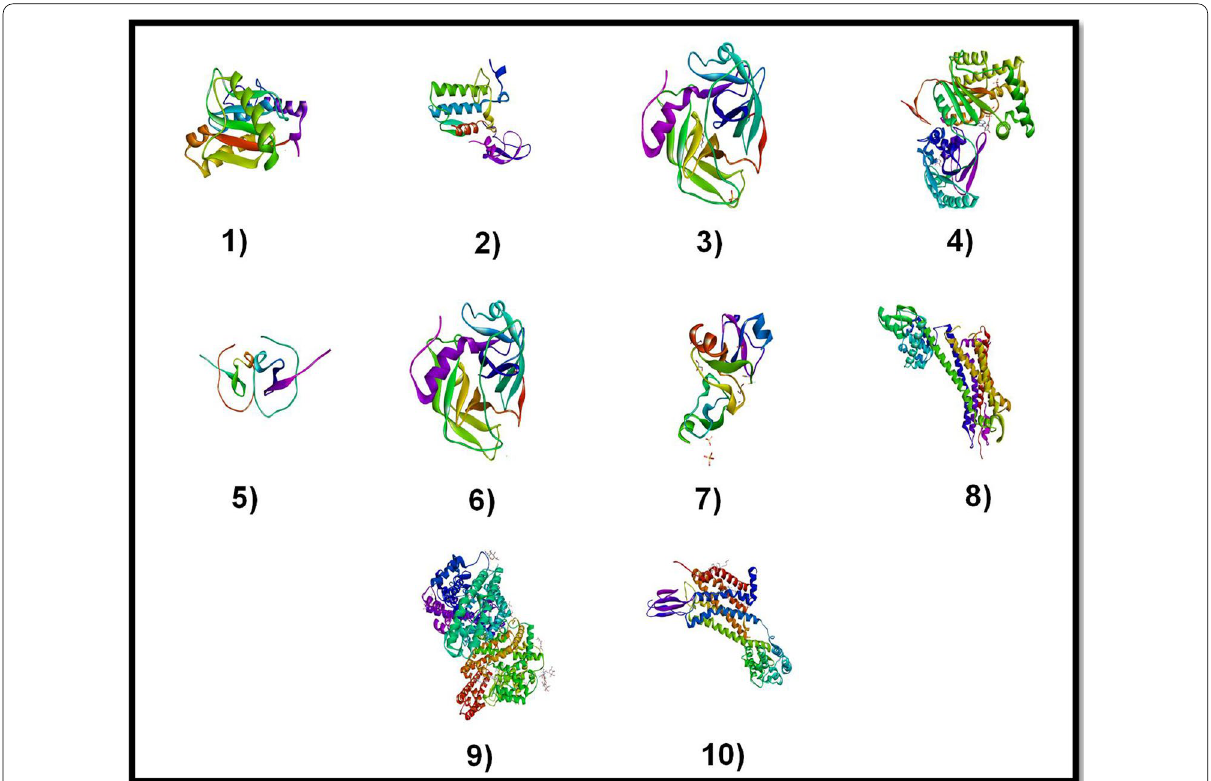
Fig. 2 Structures of different venom peptides obtained through X-ray diffraction. Description- 1 Example of Tripeptides, Acutolysin A from venom of Agkistrodon acutus. 2 Example of Phospholipase A2, structure of beta2-bungarotoxin showing potassium channel binding by kunitz modules and targeted phospholipase action. 3 Example of Serine proteinase, crystal structure of AaV-SP-II, a glycosylated snake venom serine